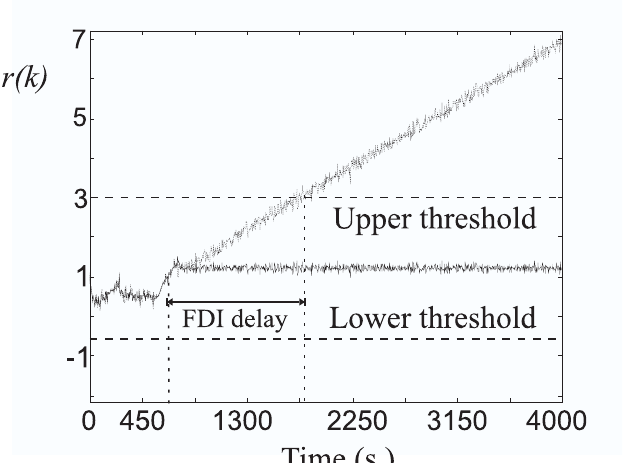
Figure 3. Detection thresholds and fault detection and isolation (FDI) delay for incipient